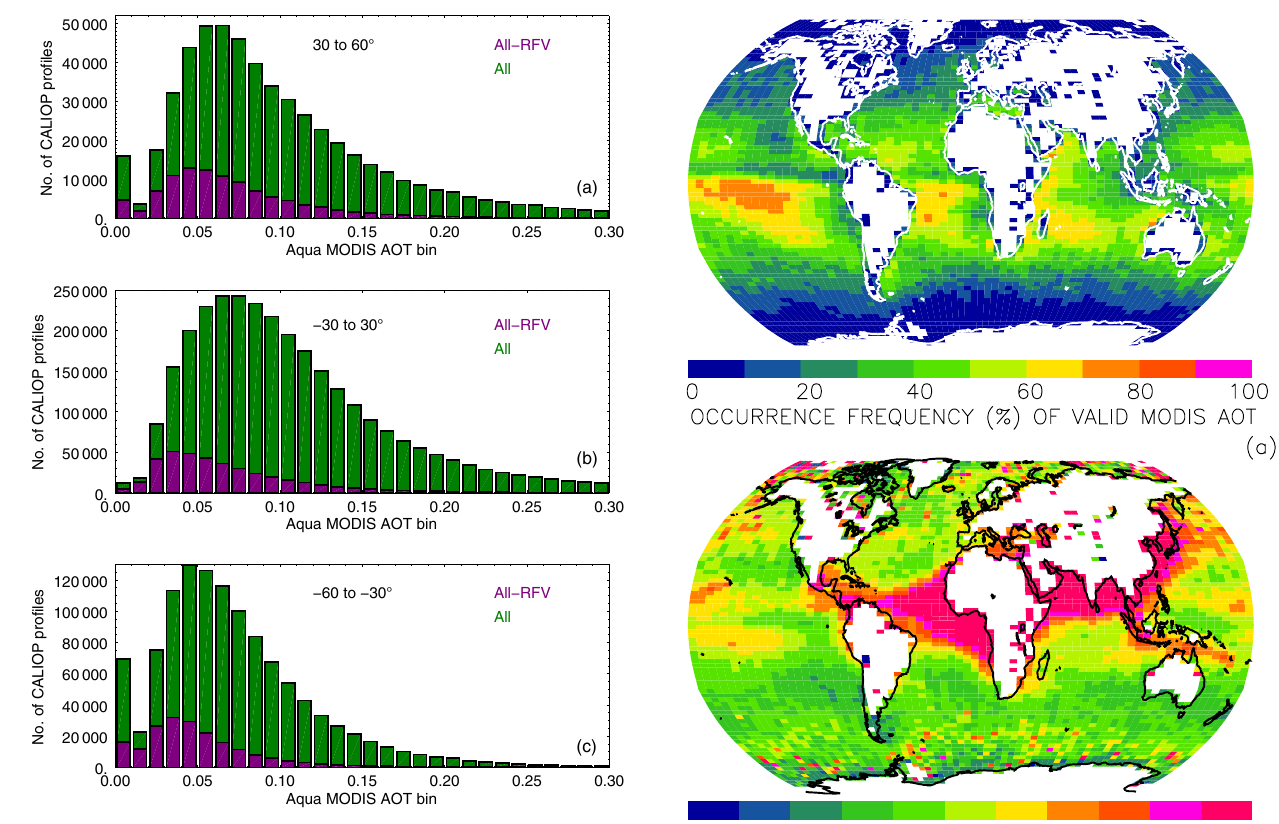
Figure 4. For 2010–2011, histograms of all over-ocean cloud-free CALIOP profiles (in green) and all-RFV profiles (in purple) as a function of collocated Aqua MODIS AOT (0.01 bins), for (a) 30 to 60 ◦ N, (b) − 30 to 30 ◦ N, and (c) − 60 to − 30 ◦ N. Figure 5. For 2010–2011, (a) frequency of occurrence (%) of valid